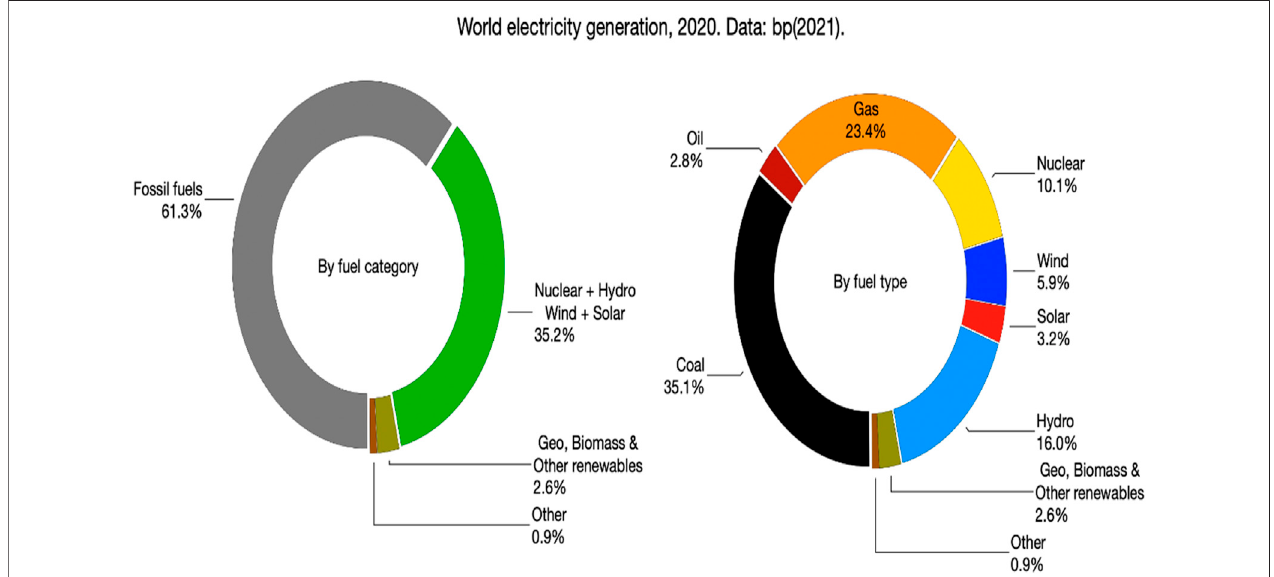
FIGURE 6 | World electricity generation by source for 2020 (BP,